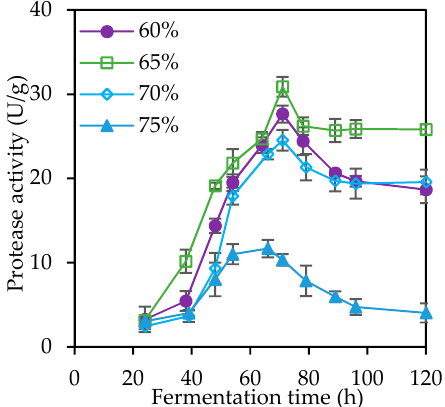
Figure 2. Effect of solid state fermentation (SSF) time in crude protease production by A. awamori , at different initial moisture contents.